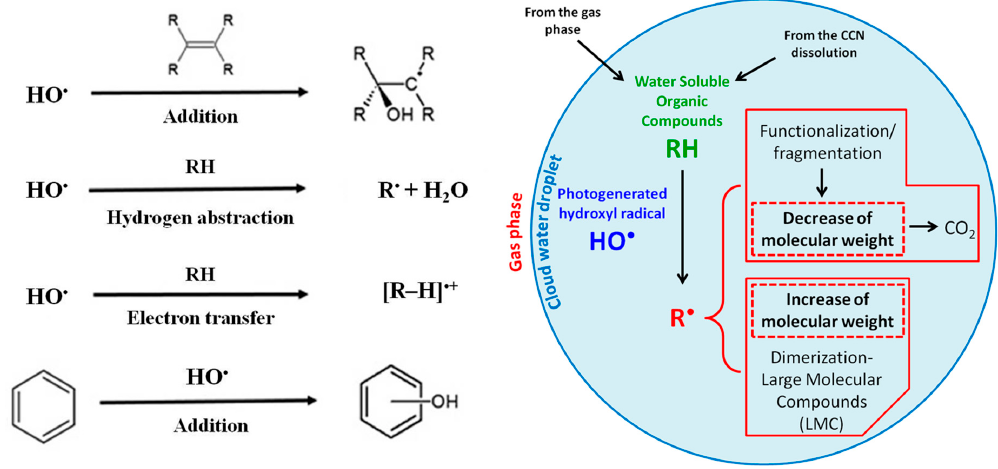
Figure 4. HO • reaction pathway ( left ) and becoming of organic compounds after reaction ( right ).